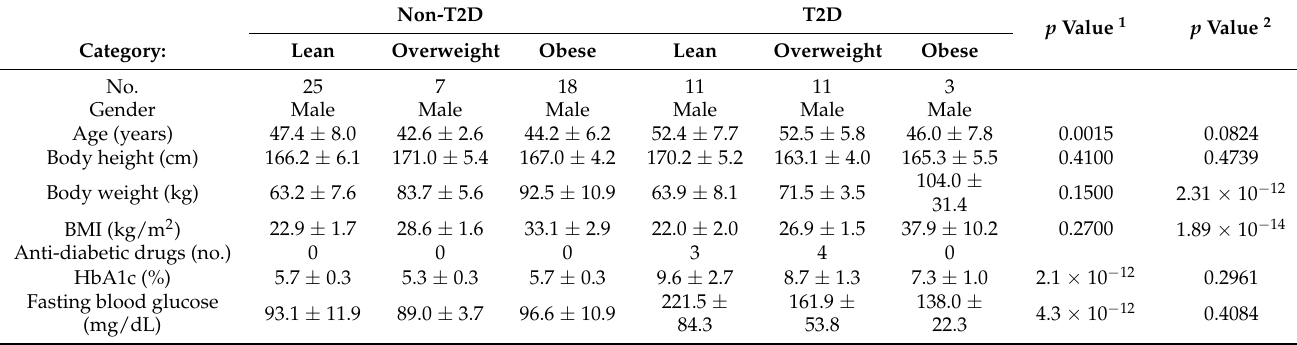
Table 1. Demographic and clinical characteristics of 75 Indonesian subjects in this study.